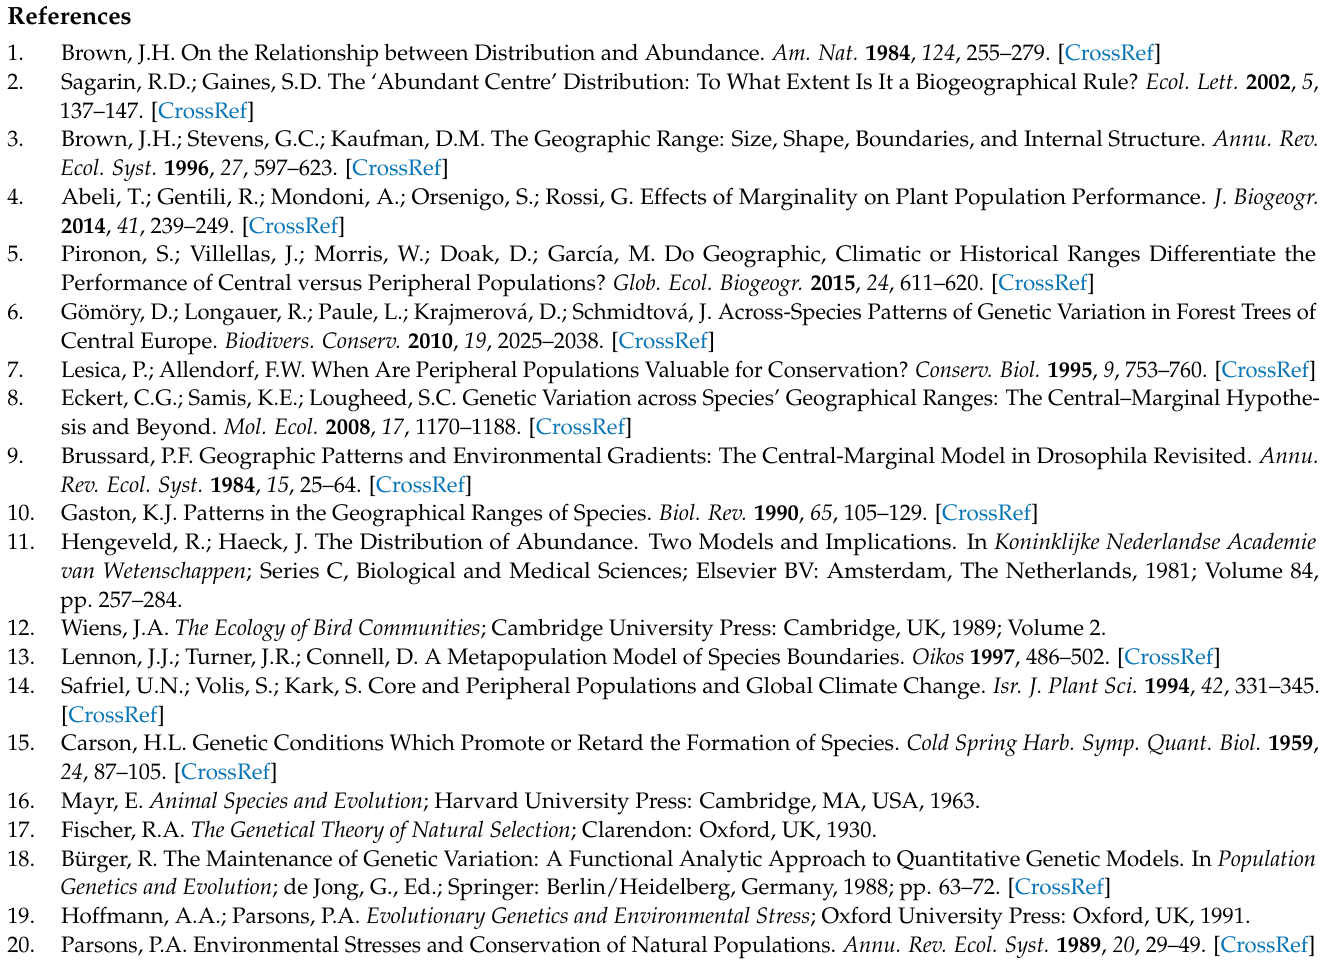
P. herrerae . Figure S6: Map showing the location of the four populations of P. leiophylla . Table S1: Geographic location of the 80 populations of six Pinus spp. and results of diversity and divergence indexes calculated using GenAlEx 6.501 (criterion 1). Table S2: Geographic location of the 80 populations of six Pinus spp. and results of diversity and divergence indexes calculated using GenAlEx 6.501 (criterion